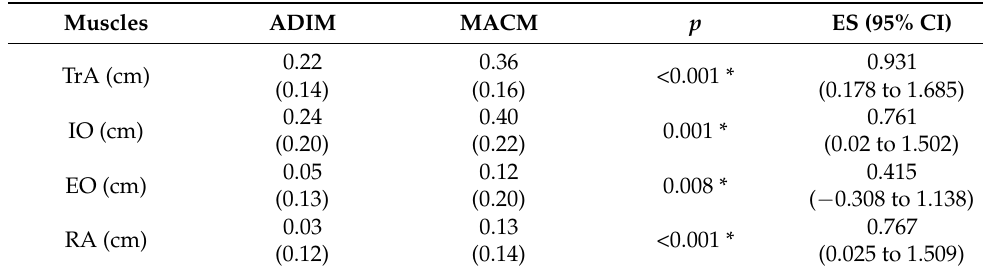
Table 2. Comparison of the ADIM and MACM to determine the changes in abdominal muscle thickness.